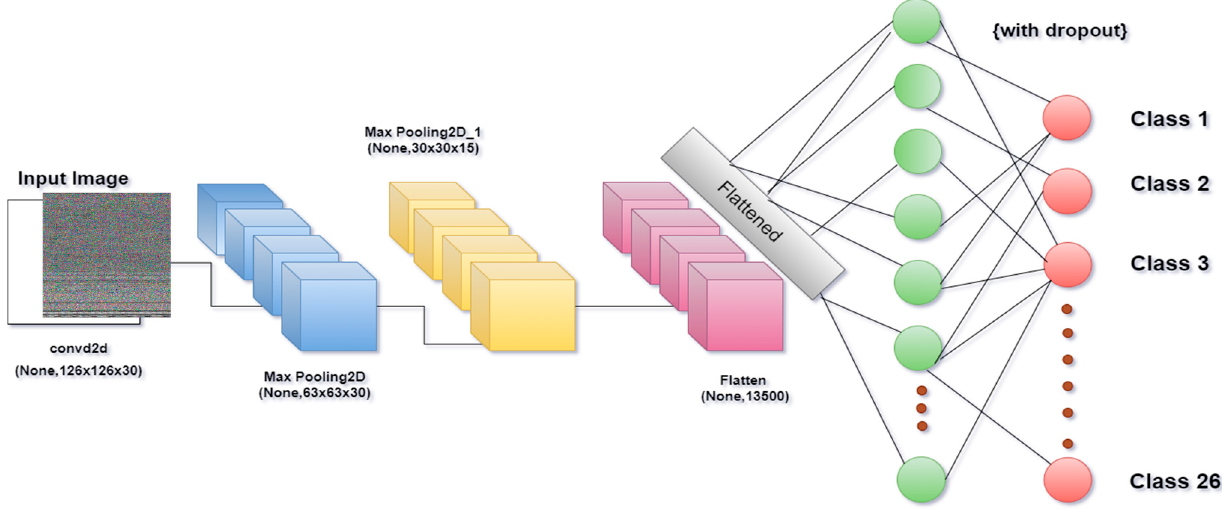
Figure 8. Convolutional Neural Network Architecture.